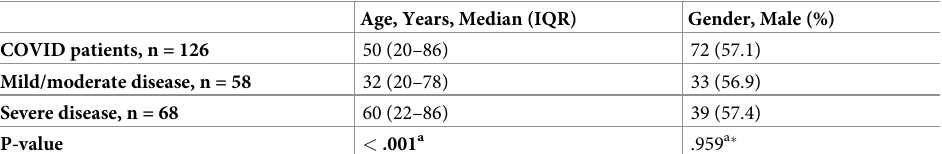
Table 1. Demographics characteristic of COVID-19